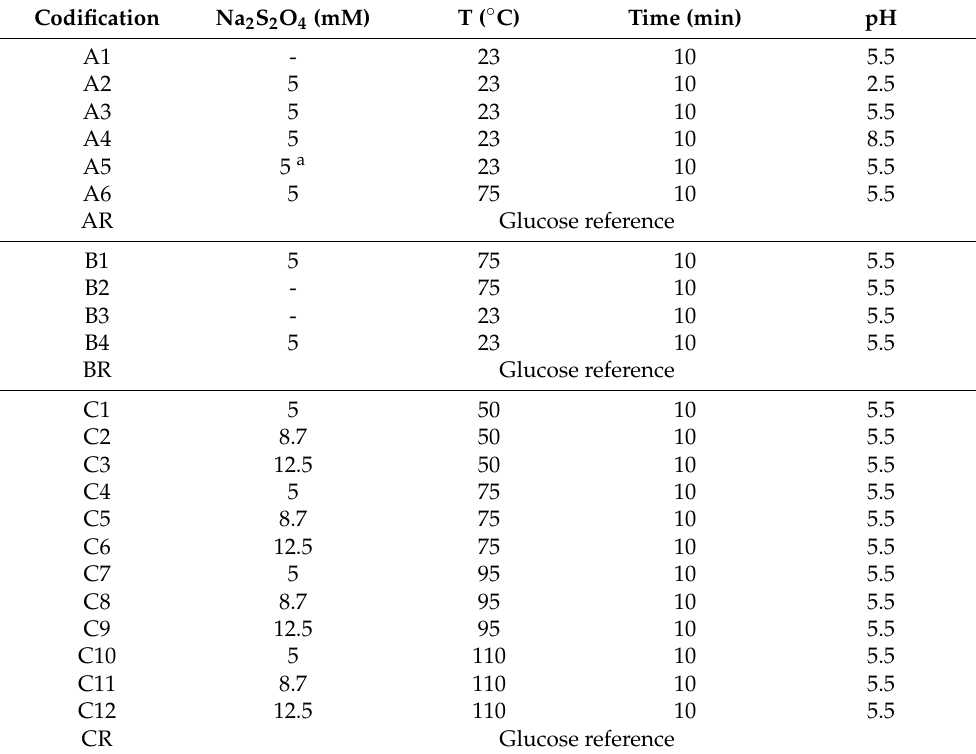
Table 1. Experimental conditions for series with varying pH and conditioning